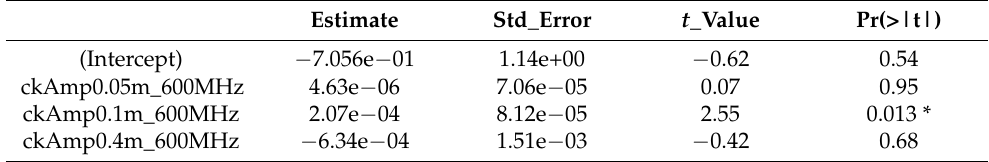
Table 4. Coefficients of the linear model.